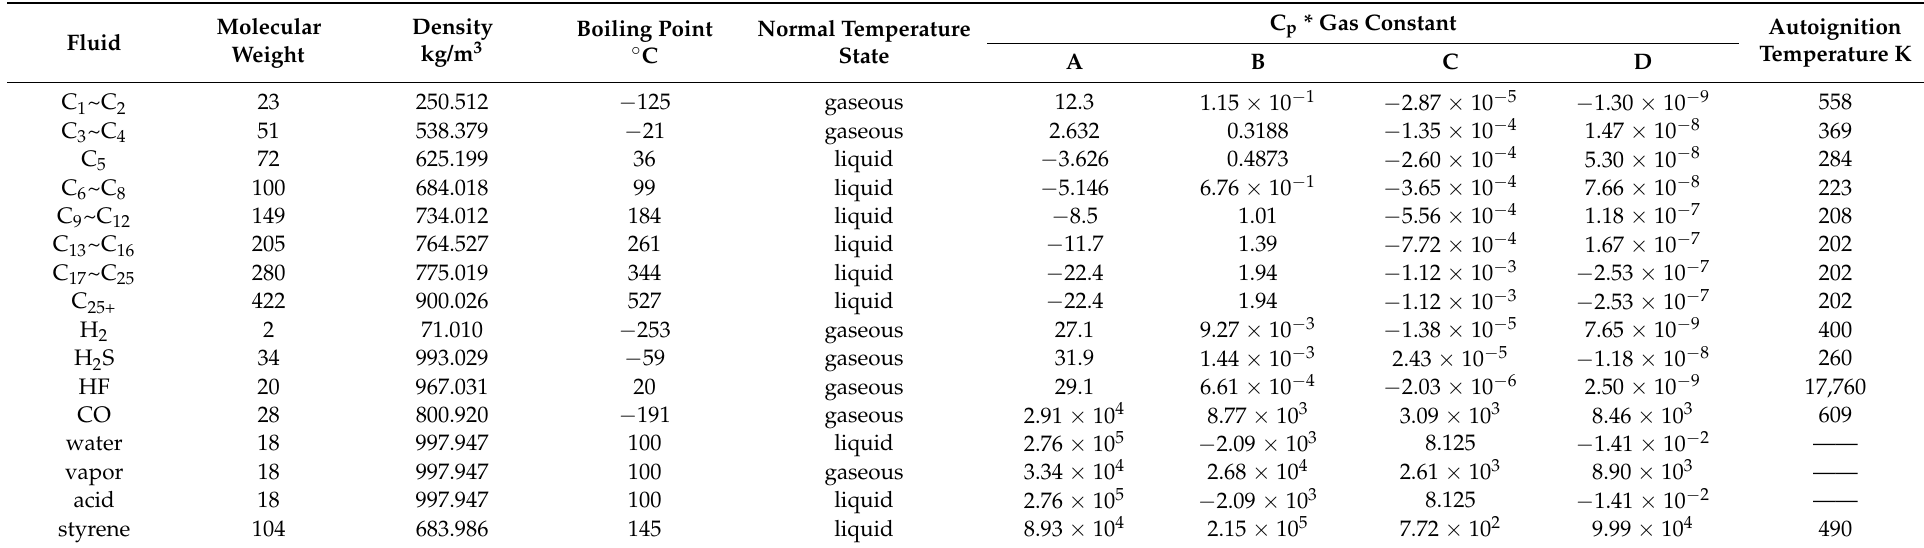
Table 1. Properties of representative fluid from